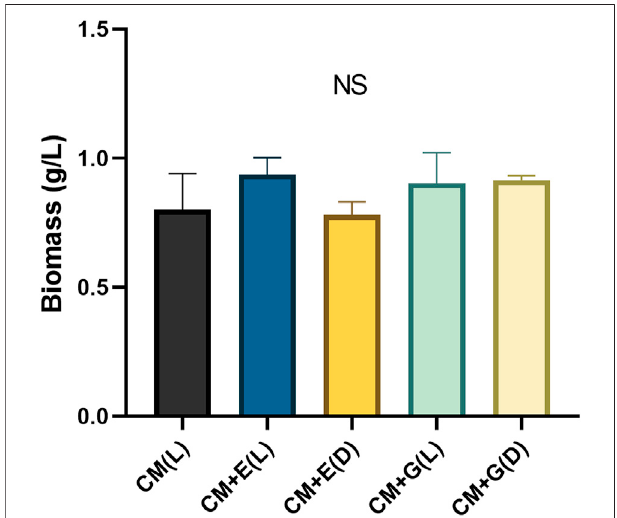
FIGURE 3 | Biomass (g/L) of E. gracilis 815 cultured under different conditions on Day 6. NS indicates no signi fi cant difference according to ANOVA test at p > 0.05.